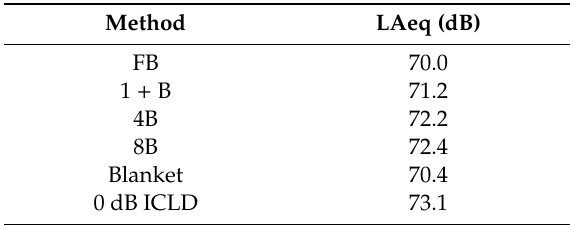
Table 2. A-weighted average sound pressure level (LAeq) for stimuli presented while using each localisation threshold